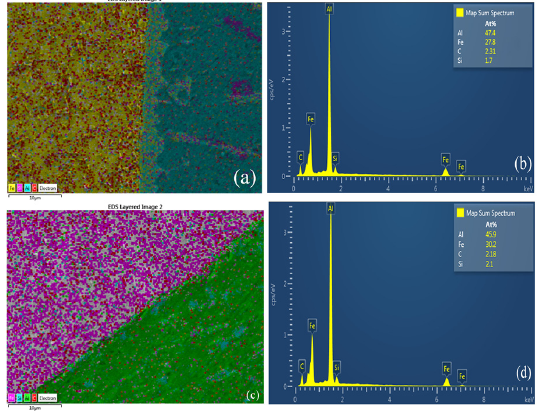
Figure 8. X-ray element mapping of butt joint of A5052 aluminum alloy and SS400 steel: ( a ) IMC layer zone; ( b ) Corresponding amounts at IMC layer; ( c ) Without IMC layer; ( d ) Corresponding amounts without IMC layer.